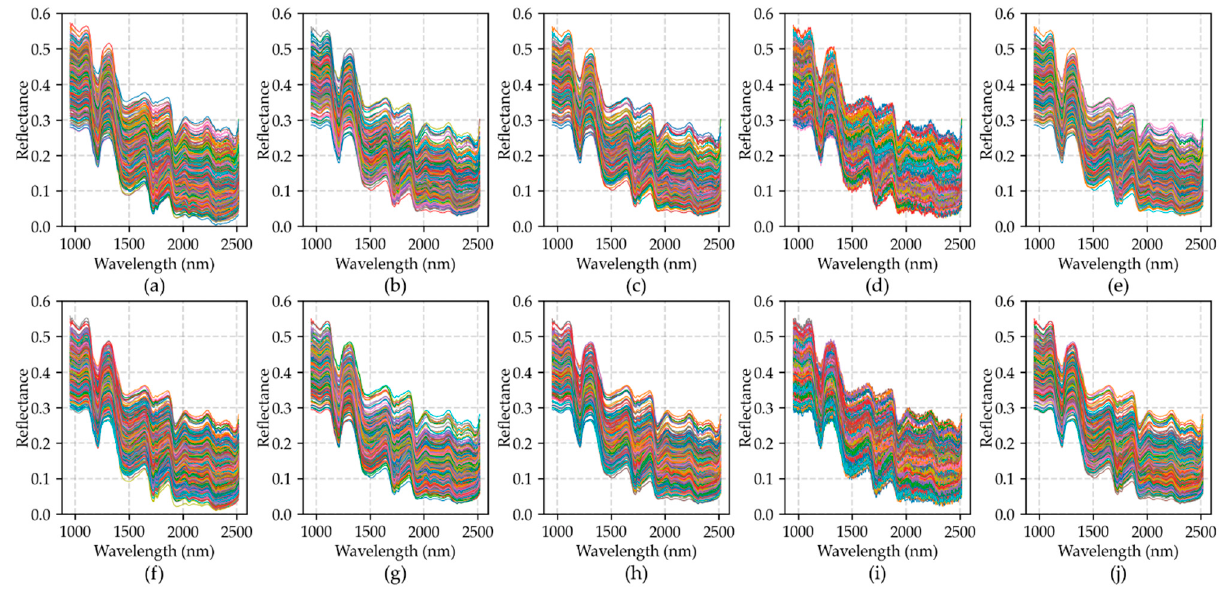
Figure 5. Data distribution after data augmentation for SLH damaged peanut class. ( a – e ) G1 and G2 data using None, Erasing, Noise, TSW and DSM respectively; ( f – j ) all gradient data using None, Erasing, Noise, TSW and DSM respectively.